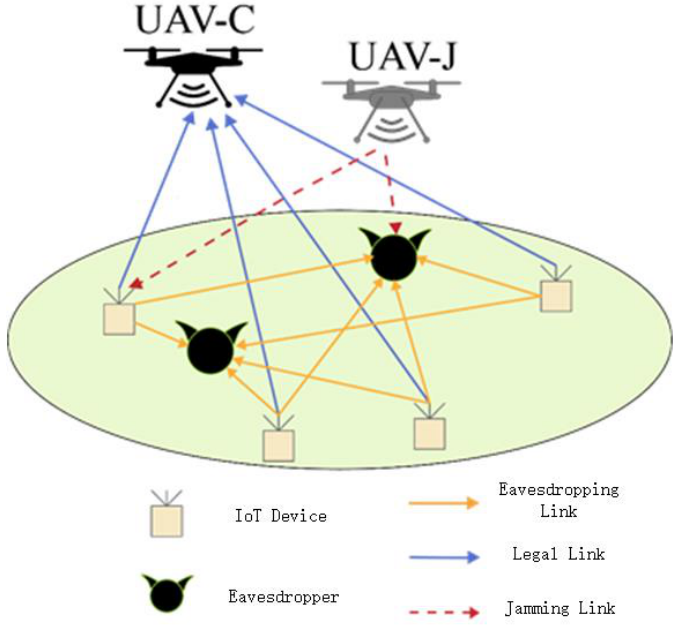
Figure 1. Model of UAV-assisted mobile edge computing